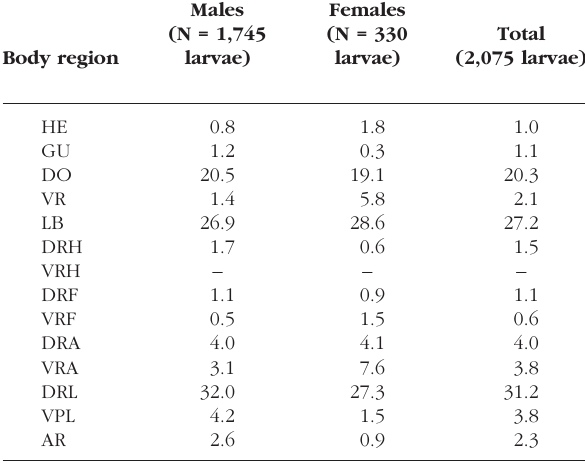
Table II. – Proportion of the infestation intensity by Hannemania sp. larvae in different regions of the body (microhabitats) of 32 males and 11 females Hylodes phyllodes at Ilha Grande, in Rio de Janeiro state, Brazil. (head = HE; gular region = GU; dorsum = DO; ventral region = VR; lateral body = LB; dorsal hand = DRH; ventral hand = VRH; dorsal foot = DRF; ventral foot = VRF; dorsal arm = DRA;